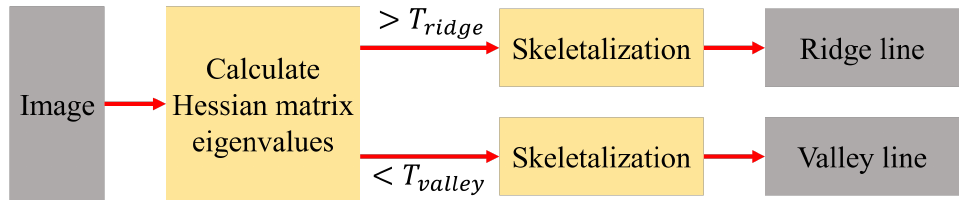
Figure 5. The process of extracting the mountain range